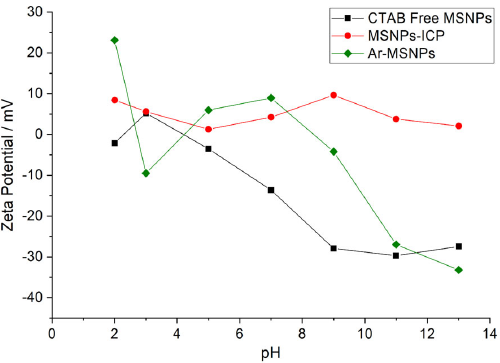
Figure 3. Comparison of zeta potential value between CTAB free MSNPs, MSNPs-ICP, and Ar-MSNPs in aqueous solutions at different pH values.